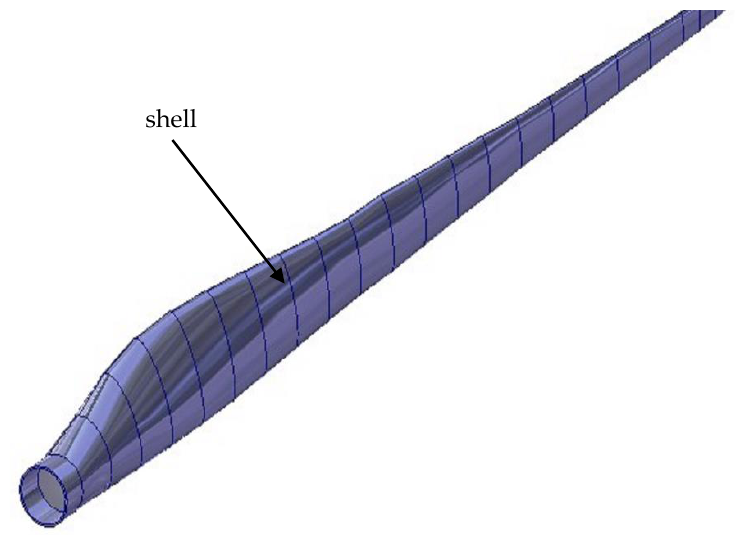
Figure 2. The model of the wind turbine blade in the CAD software.